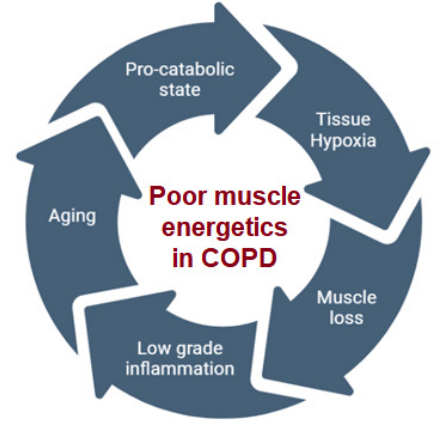
Figure 1. Mechanisms leading to poor muscle